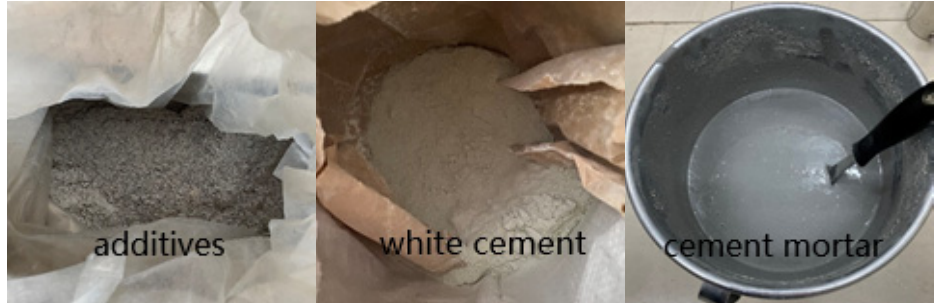
Figure 3. Cement mortar and raw materials. Table 5. Properties of the Portland cement.